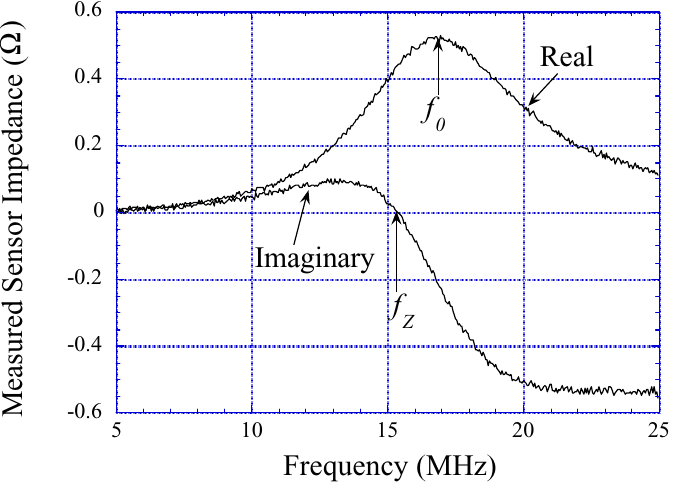
Figure 3. The impedance spectrum of the sensor after the antenna impedance is subtracted. The resonant frequency f is defined as the maximum of the real impedance, while the 0